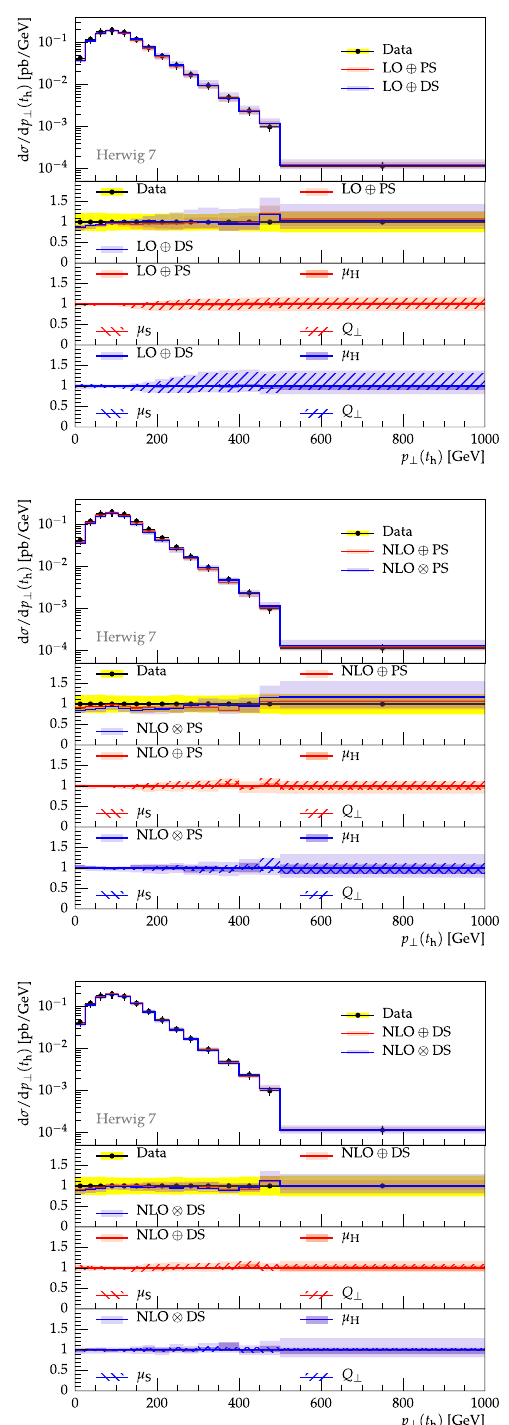
Fig. 9 The transverse momentum of the reconstructed hadronically decaying top quark measured by ATLAS in semileptonic 8 TeV pp → t ¯ t events [64]. The top plots shows leading-order production with angular-ordered (PS) and dipole (DS) parton showers, the middle plot NLO production matched to the angular-ordered parton shower while the bottom plot shows NLO production matched to the dipole shower. Two NLO matching schemes, MC@NLO-type (NLO ⊕ ) and Powheg- type (NLO ⊗ ), are used